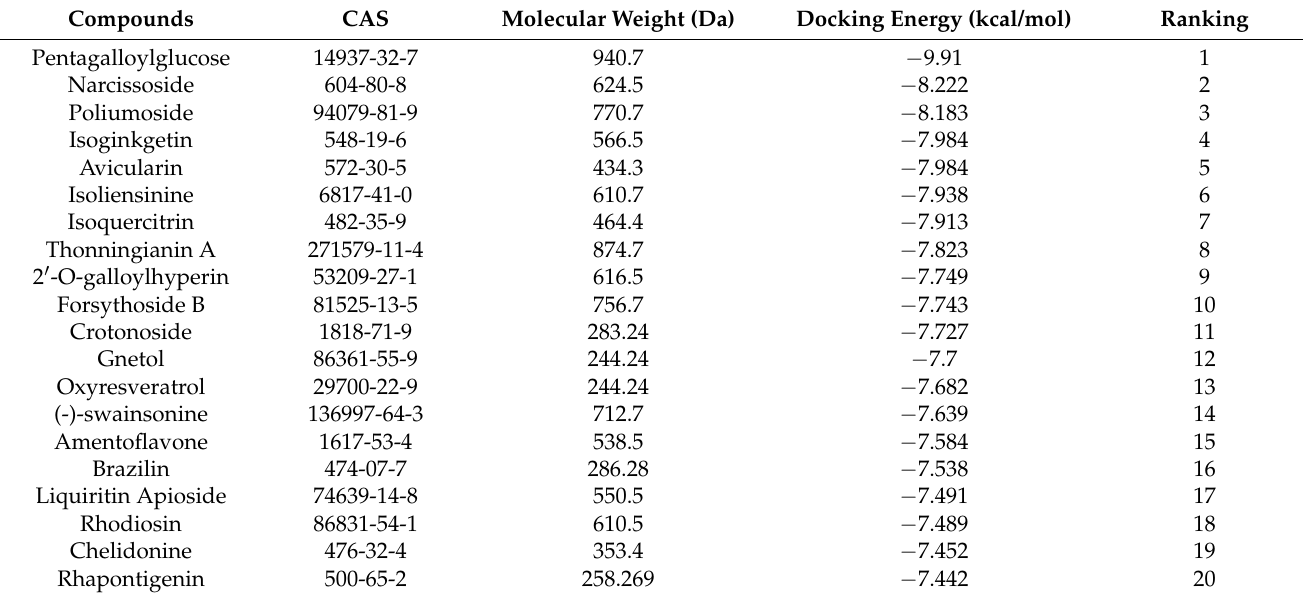
Table 1. Top 20 phytochemical compounds from virtual